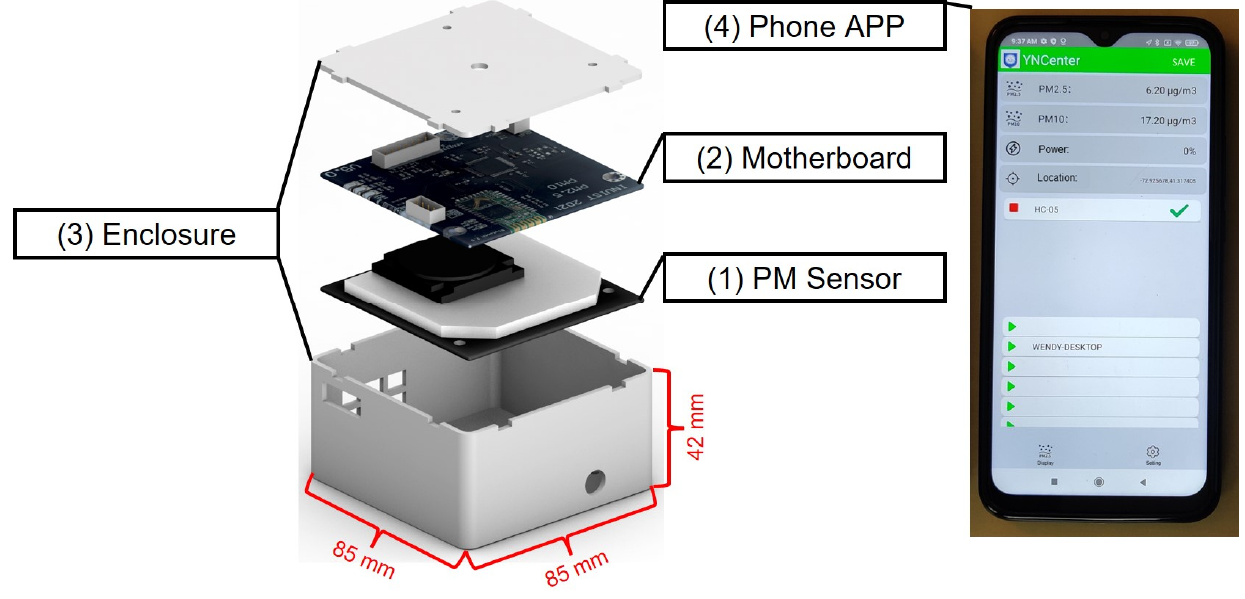
Figure 1. The four major modules of a Smart-P monitor.